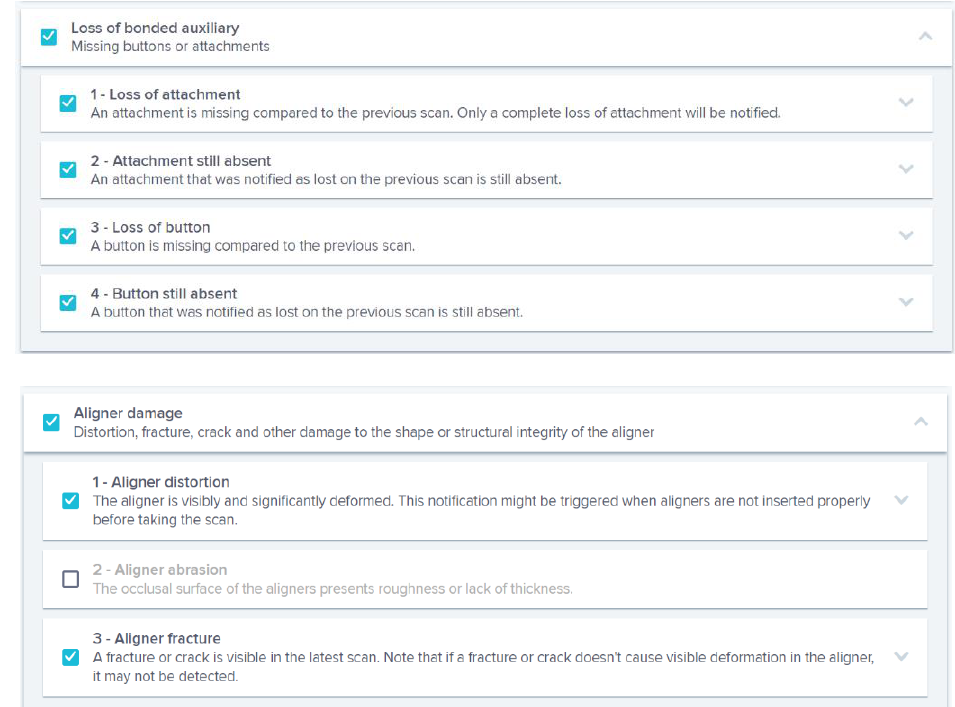
Figure 5. Protocol for treatment of the aligners by the DM system.